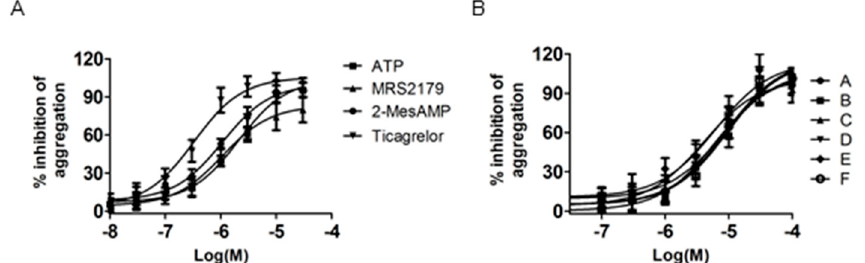
Figure 2. Inhibition of ADP-induced platelet aggregation by six candidate antagonists of P2Y12. The reference compounds ATP, MRS2179, 2-MeSAMP, and AZD6140 were used as ADP, P2Y1, and P2Y12 receptor antagonists. ( A ) references and ( B ) the six candidate compounds inhibited platelet aggregation induced by 20 μ M ADP. Data are representative of two experiments performed in triplicate and are expressed as mean ± SD (see also Table 1). Table 1. Competitive binding affinities of selected compounds for rhP2Y12 receptor. Table 1. Inhibition of ADP-induced platelet aggregation of selected